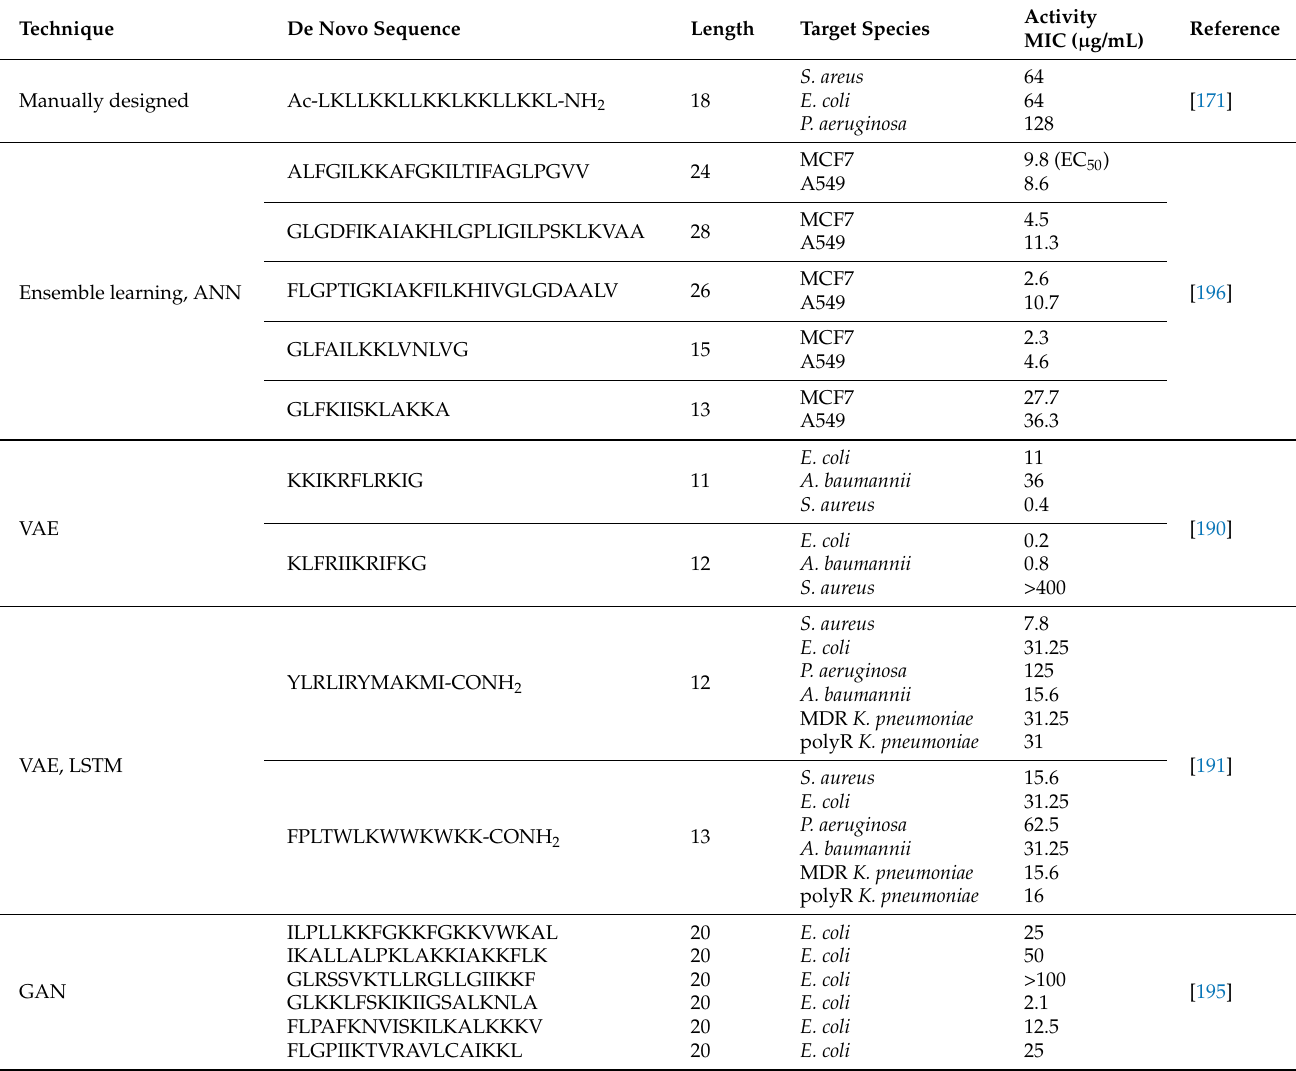
Table 2. Studies of de novo design with successful novel sequences and experimental assay values.